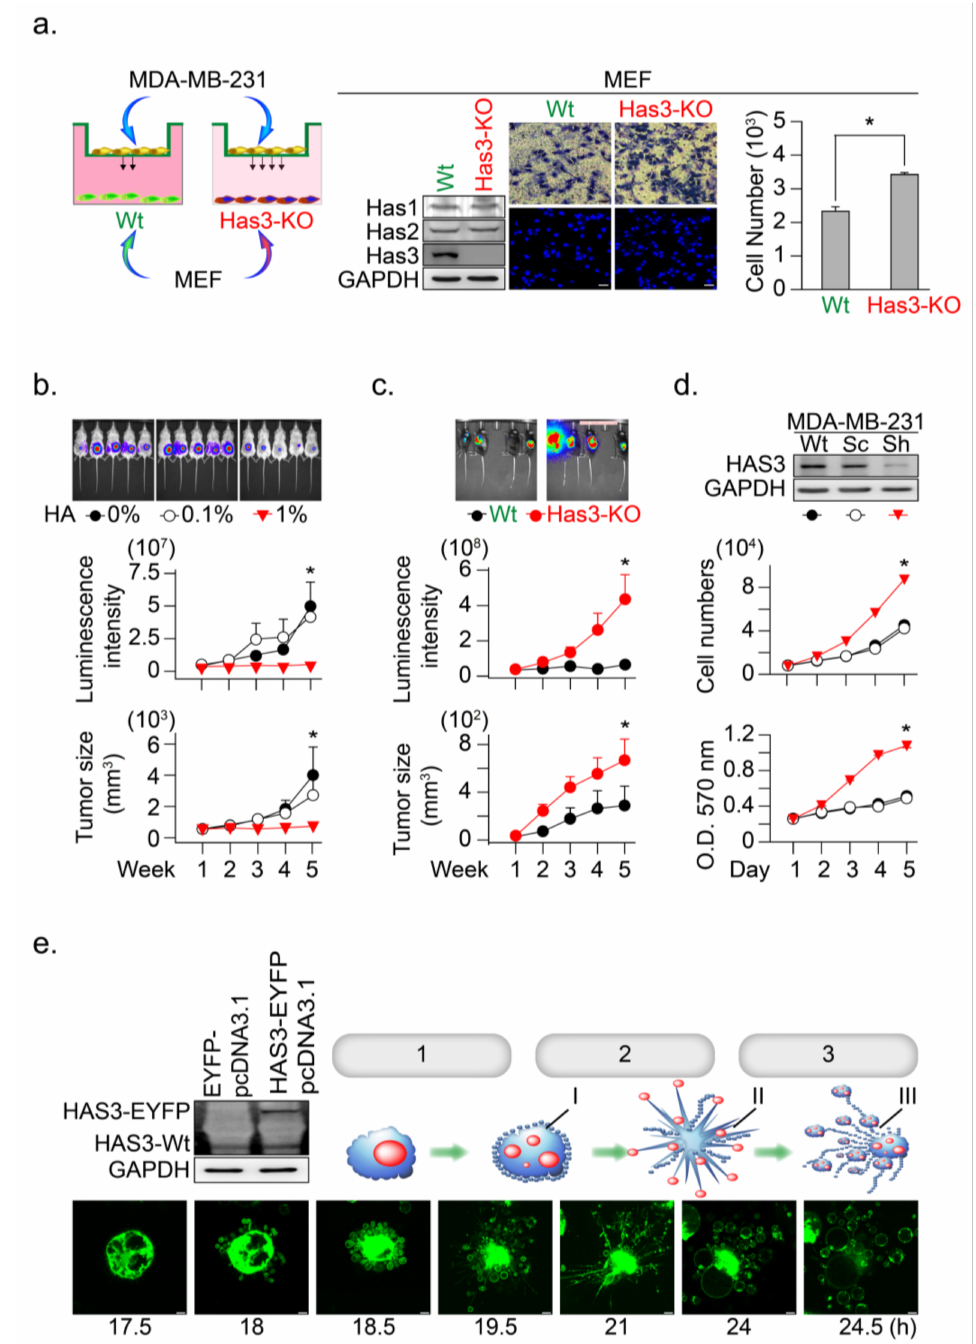
Figure 2. HAS3 deficiency in normal stroma tissue promoted breast cancer tumorigenesis. ( a ) A Transwell assay was conducted to test the anti-migratory effects of condition medium from primary cultured mouse MEF. The MEF derived from wild type and HAS3 KO mice were seed in the lower chamber coculture with the MDA-MB-231 cancer cells in the upper chamber for 24 h. The data shown indicate the number of migrated breast cancer cells. Error bars indicate 95% confidence intervals. The data are presented as the mean ± SD. Data were analyzed with a paired t-test, and the presented p -values are two-sided. * p = 0.00061 compared with the control group. We performed western blot analysis, and the results indicated that HAS3 KO did not affect the HAS2 and HAS1 protein levels in both MEF cells. Magnification, 200 × ; scale bar, 50 µ m; ( b ) In vivo HA exposure inhibited